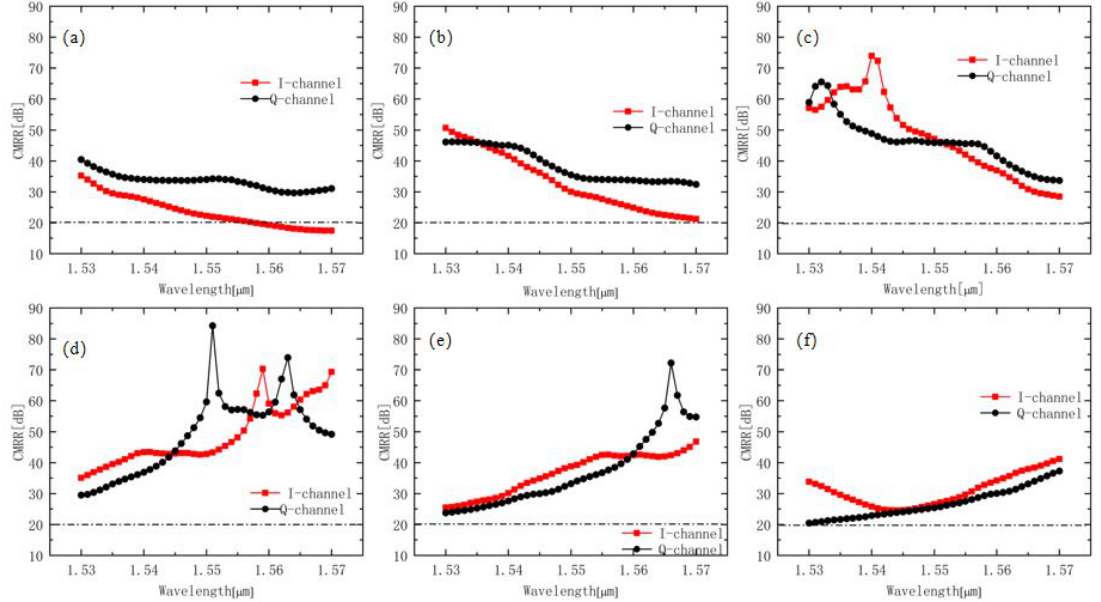
Figure 5. Simulated CMRR of the hybrid with different widths of ( a ) 19.7μm, ( b ) 19.8μm, ( c ) 19.9μm, ( d ) 20.1μm, ( e ) 20.2μm, and ( f ) 20.3μm across the C-band.